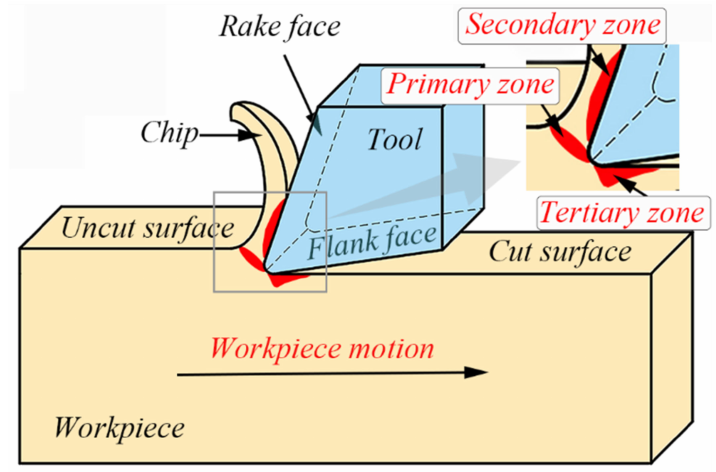
Figure 8. The schematic diagram of the cutting process and three shear zones [5].